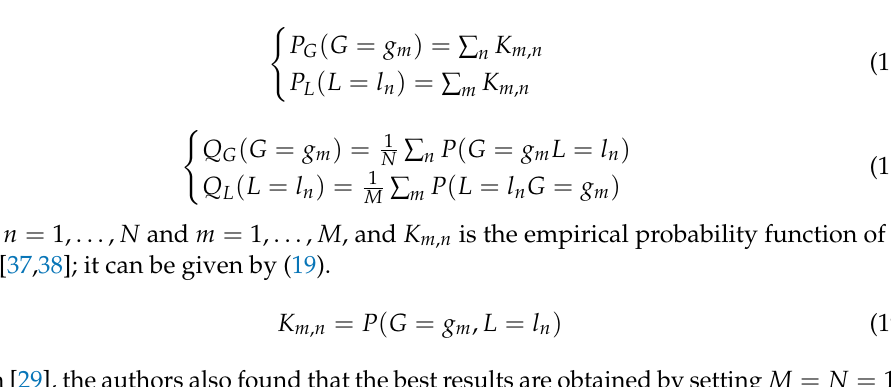
Table 2. Extracted features based on GM and LoG. Feats Feature Description f1–f10 marginal probability functions of GM f11–f20 marginal probability functions of LoG f21–f30 measure of the overall dependency of GM f31–f40 measure of the overall dependency of